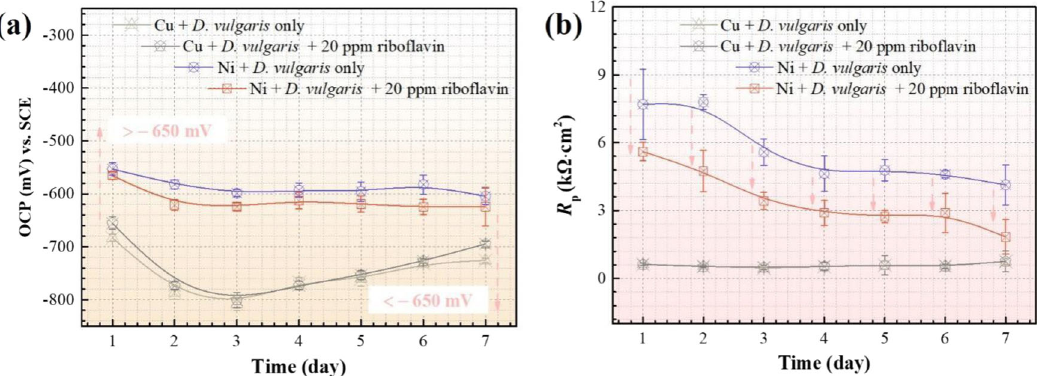
Fig. 10 OCP and R p. Variation of the OCP ( a ) and R p ( b ) of the Cu and Ni coupons during the 7-d incubation in the D. vulgaris media without and with ribo fl avin. (Error bars stand for the standard deviations from at least three independent